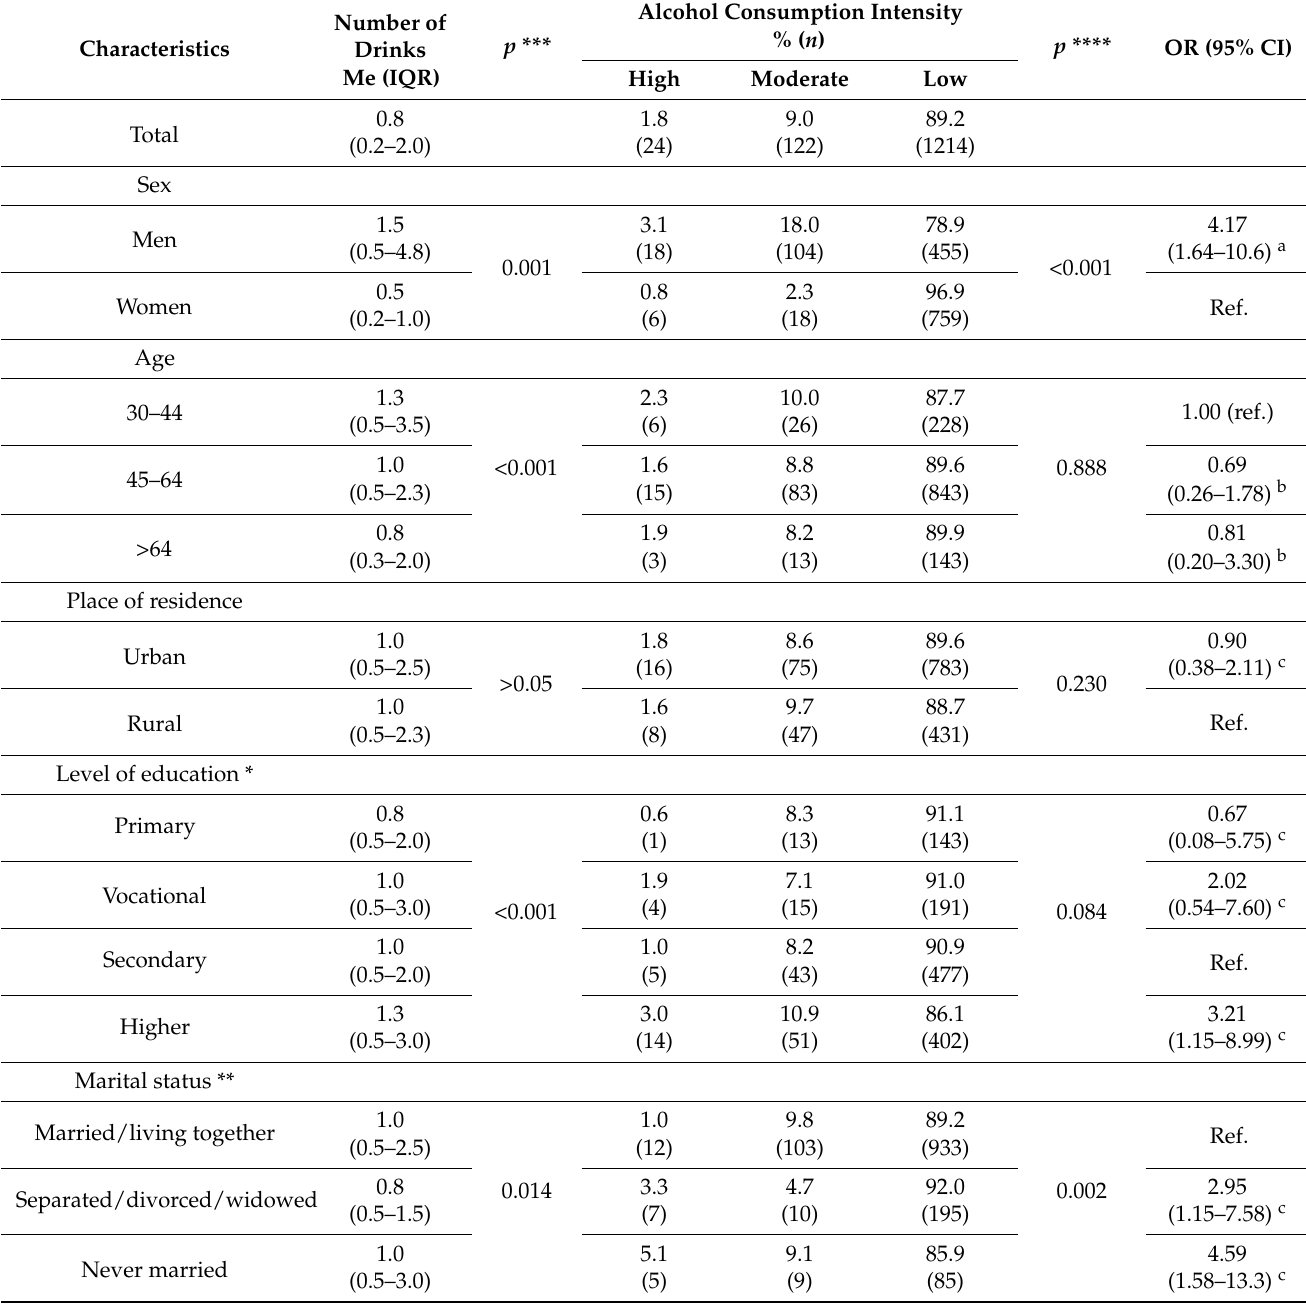
Table 2. Baseline characteristics in current drinkers by level of intake